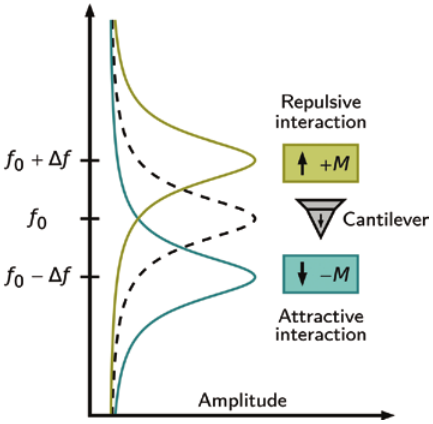
due to attractive (blue) Figure 2: Shift of the resonance frequency f 0 and repulsive (green) interaction between the ferromagnetic sample (cid:31) with magnetization M and the permanently magnetized probe. The amplitude of the oscillation is kept at a constant level by the posi- tive feedback circuit. Damping is not considered in this